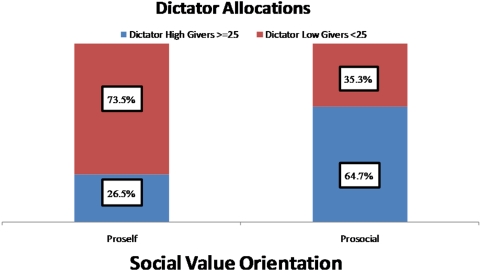
Cross tabulation of Dictator and SVO allocation of funds.Cross tabulation of Dictator giving with Social Value Orientation (SVO). High givers in the DG were significantly more likely to maintain prosocial value orientations as compared to low givers.